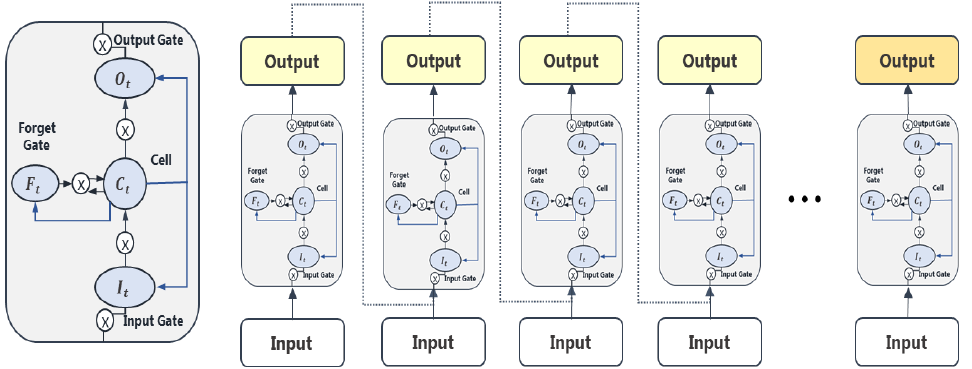
Figure 3. Memory block and long short-term memory structure.